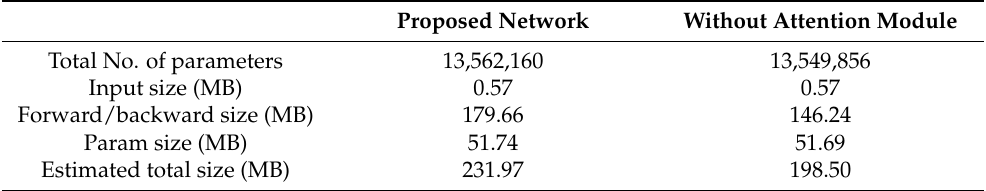
Table 2. Comparison of additional computational cost of attention